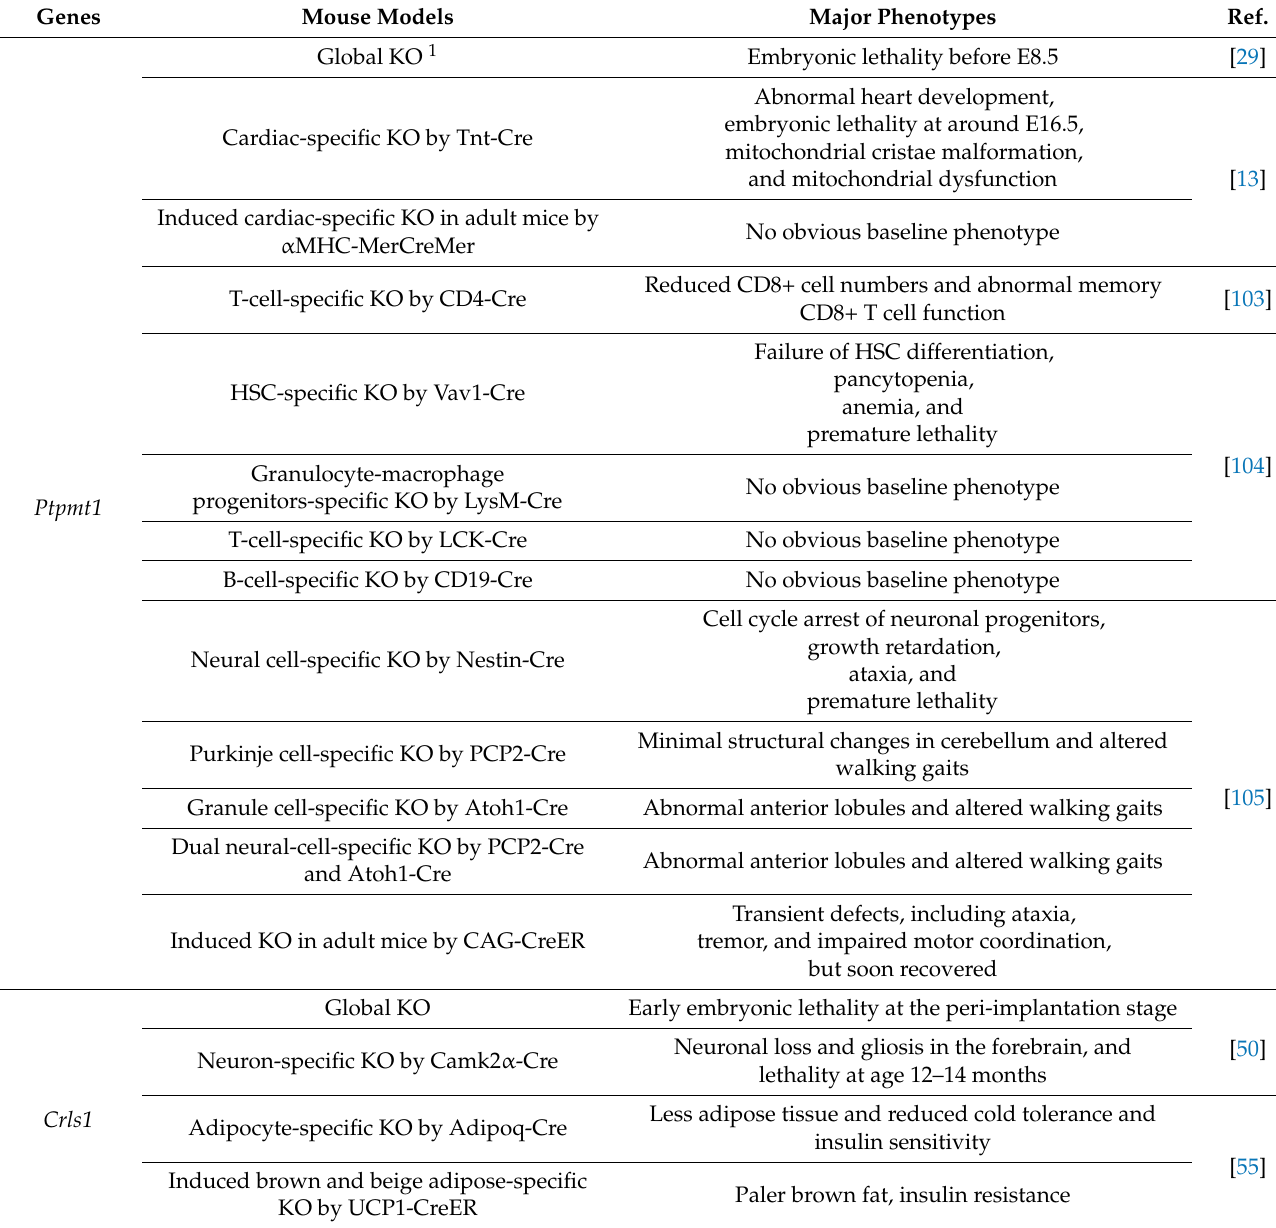
Table 1. Genetically engineered mouse models of Barth syndrome and CL-deficiency-related